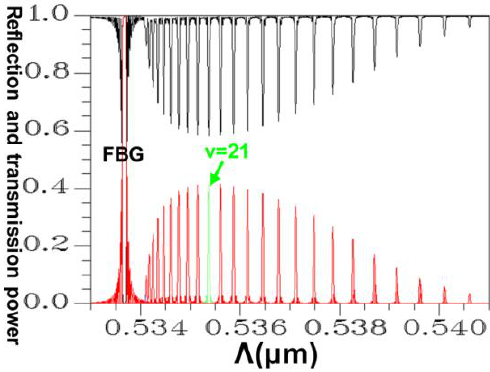
Figure 19. Plot between the FBG period and the reflection (or transmission) power for the total coupling from HE to a counterpropagating cladding mode ( ν = 21) with 11 Λ = 0.53537 μm. The black line expresses the core mode transmission power. The red line expresses the cladding mode ( ν = 21) reflection